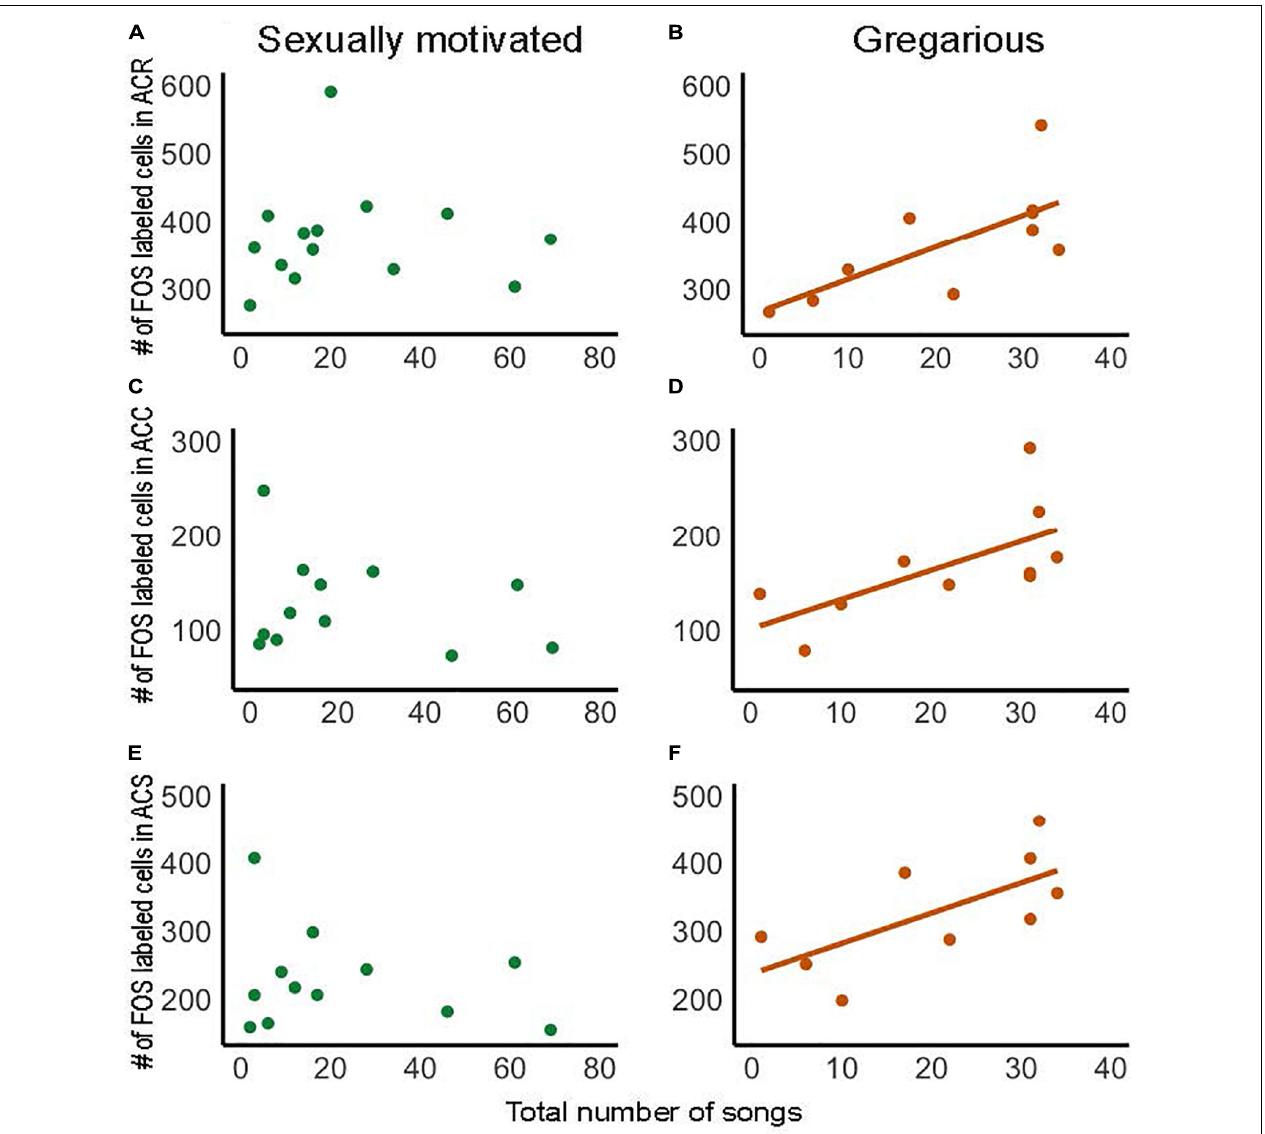
FIGURE 5 | Numbers of FOS labeled cells within each subdivision of NAc correlate positively with the production of gregarious but not sexually motivated song in male starlings. Correlations in panel (A,B) show the rostral pole of the nucleus accumbens (ACR), (C,D) the accumbens core (ACC), and (E,F) the accumbens shell (ACS). Each point represents an individual bird. Presence of regression line indicates statistical significance [ (B) : R 2 = 0.49, p = 0.022; (C) : R 2 = 0.42, p = 0.041, (D) : R 2 = 0.46, p = 0.046]. Figure redrawn with permission from Polzin et al. (2021).